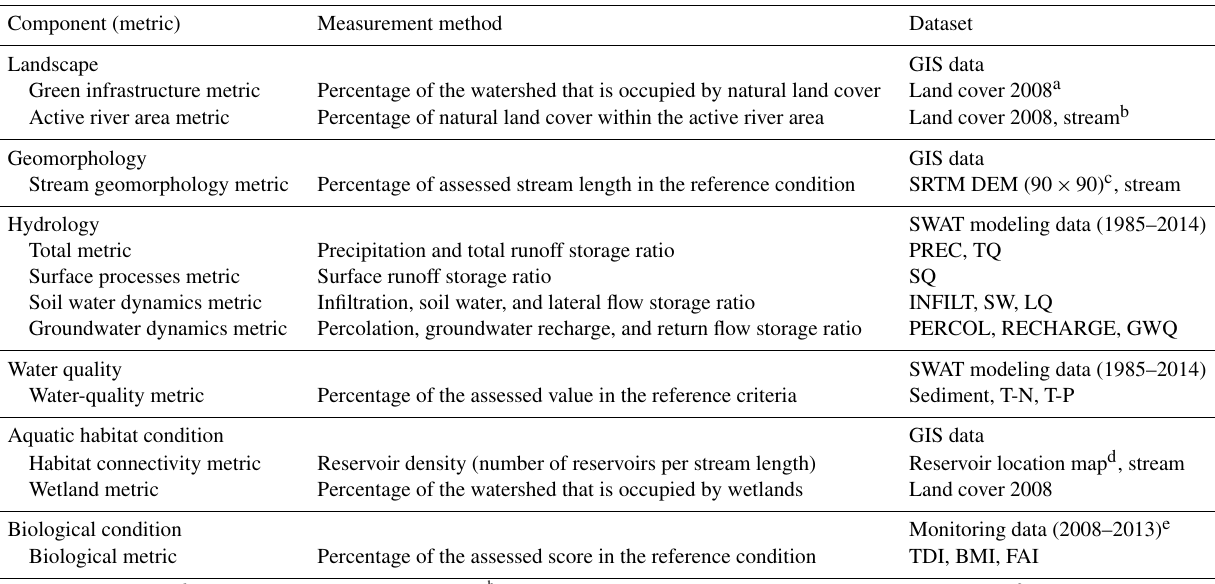
Table 1. Metrics and summary dataset that was used to assess the watershed health in the study watershed. Component